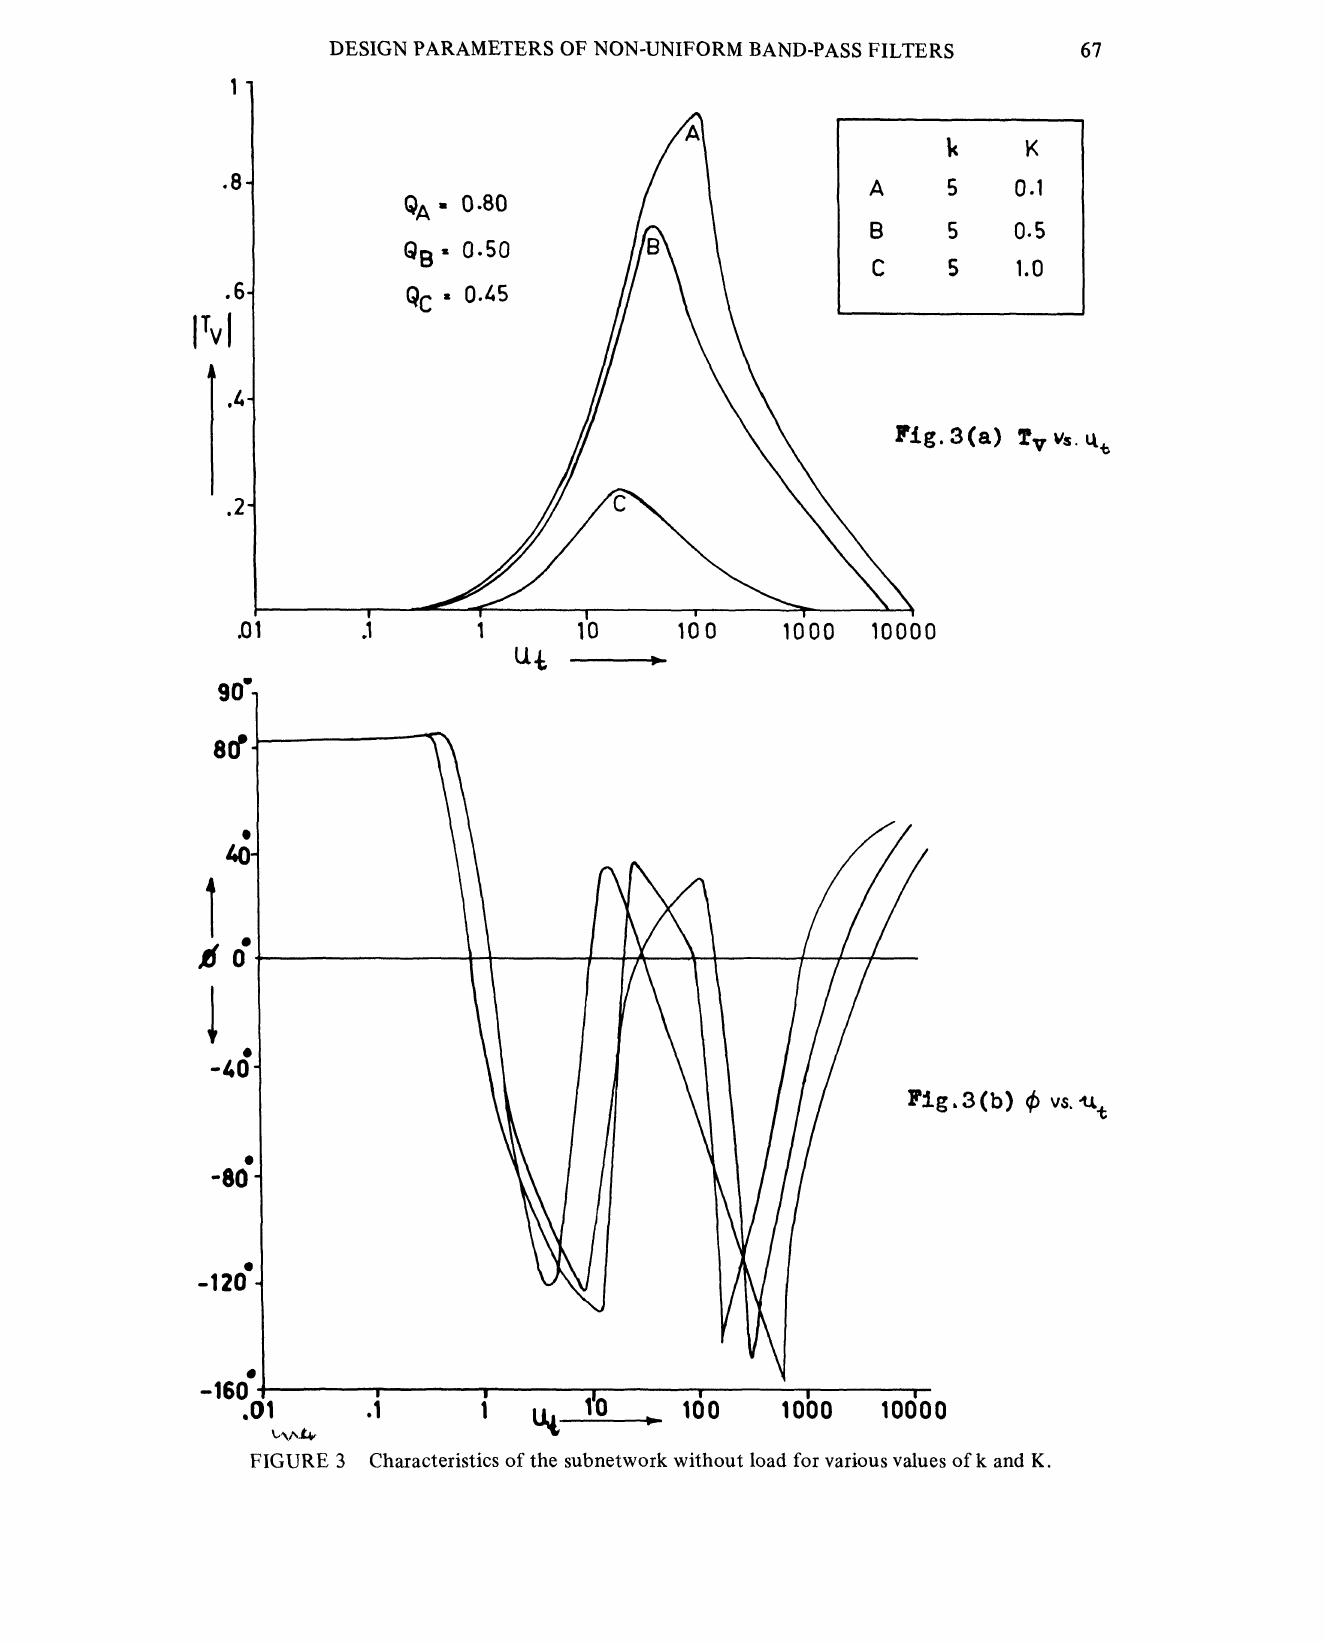
’ o 60 obo odoo Characteristics of the subnetwork without load for various values of k and